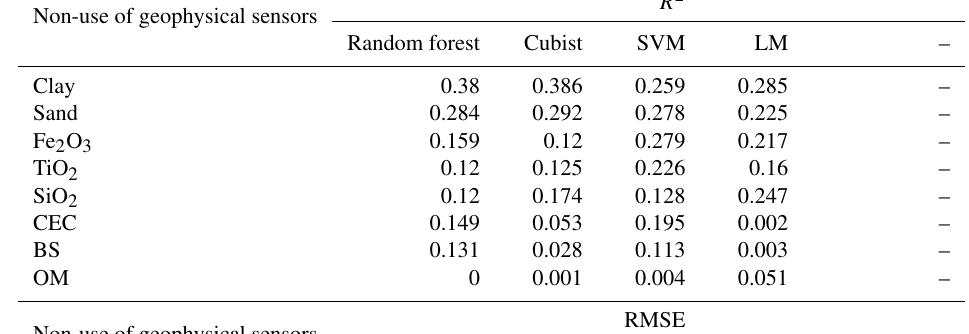
Table 2. Model performance for non-use geophysical sensors, for all soil attributes, based on R 2 , RMSE, MAE, and NULL_RMSE. Non-use of geophysical